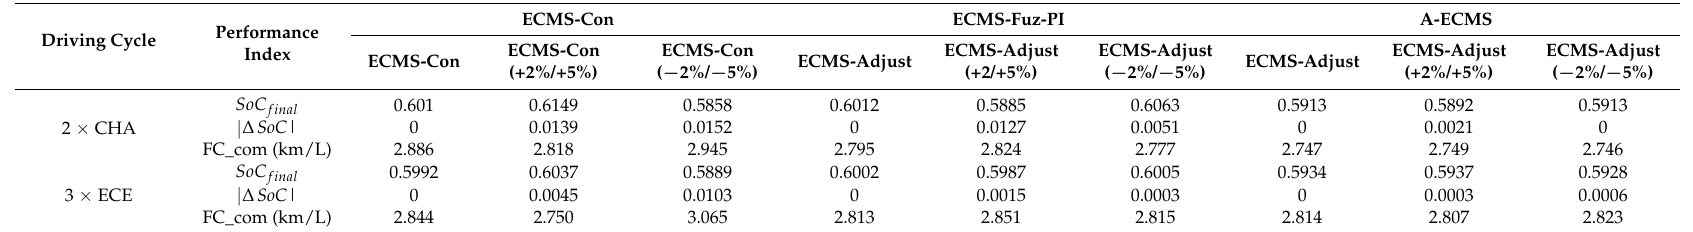
Table 4. Comparison of performances of different control